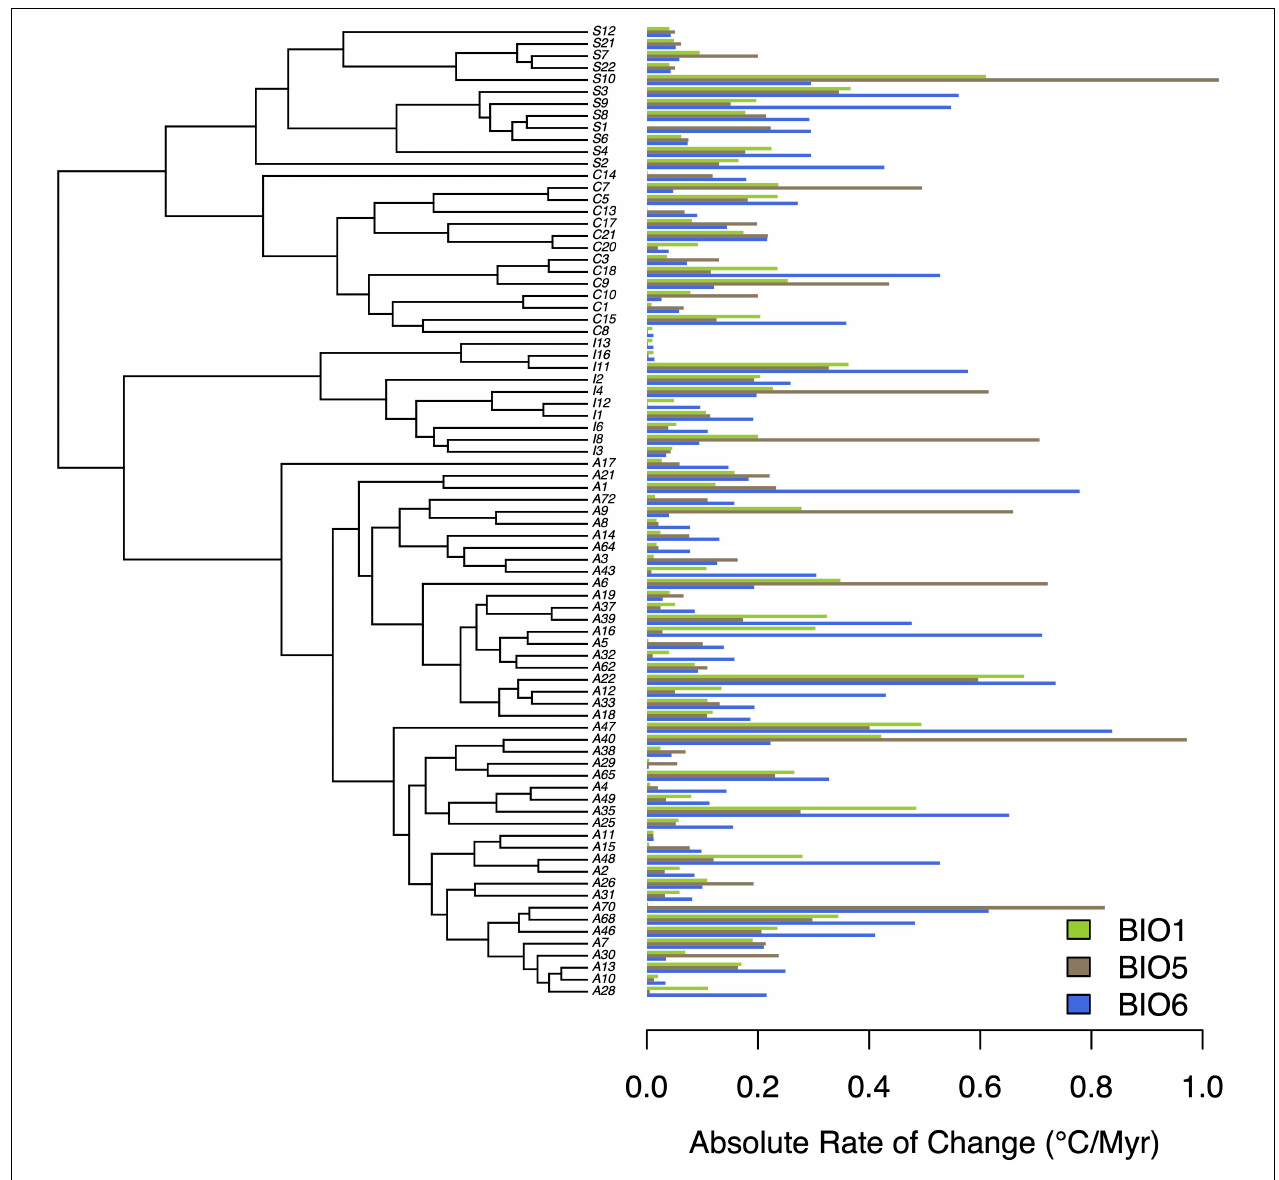
FIGURE 5 | Absolute rates of climatic niche evolution for three thermal variables (BIO1, BIO5, BIO6). Rate estimates are in ◦ C/Myr, and are plotted alongside the MCC tree from previous work (Nelsen et al.,